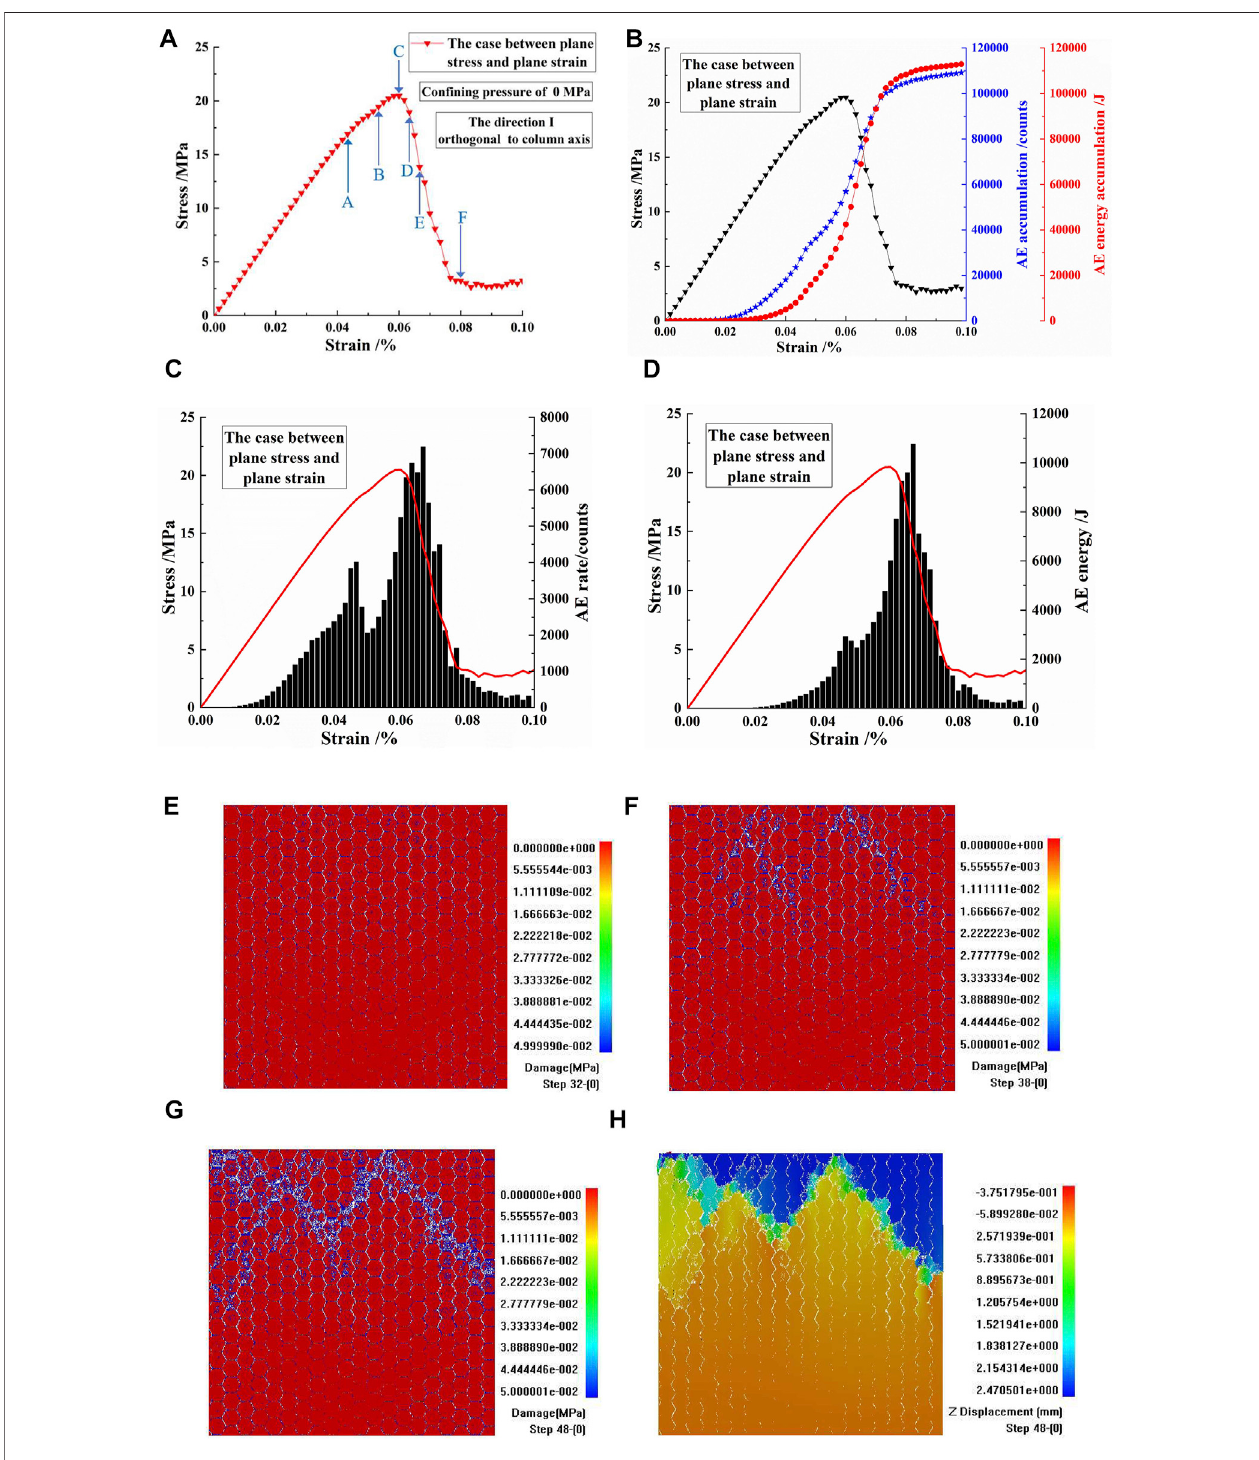
FIGURE 7 | (A,B) The stress – strain curves, acoustic emission (AE) accumulations, and AE energy accumulations of columnar jointed basalts (CJBs) in direction I orthogonal to the column axis for the case between plane stress and plane strain, with a con fi ning pressure of 0 MPa. (C , D) The stress – strain curve, AE rate, and AE energy of CJBs. (E – H) Damage and displacement diagrams corresponding to points B, D, and F of the stress – strain curve.